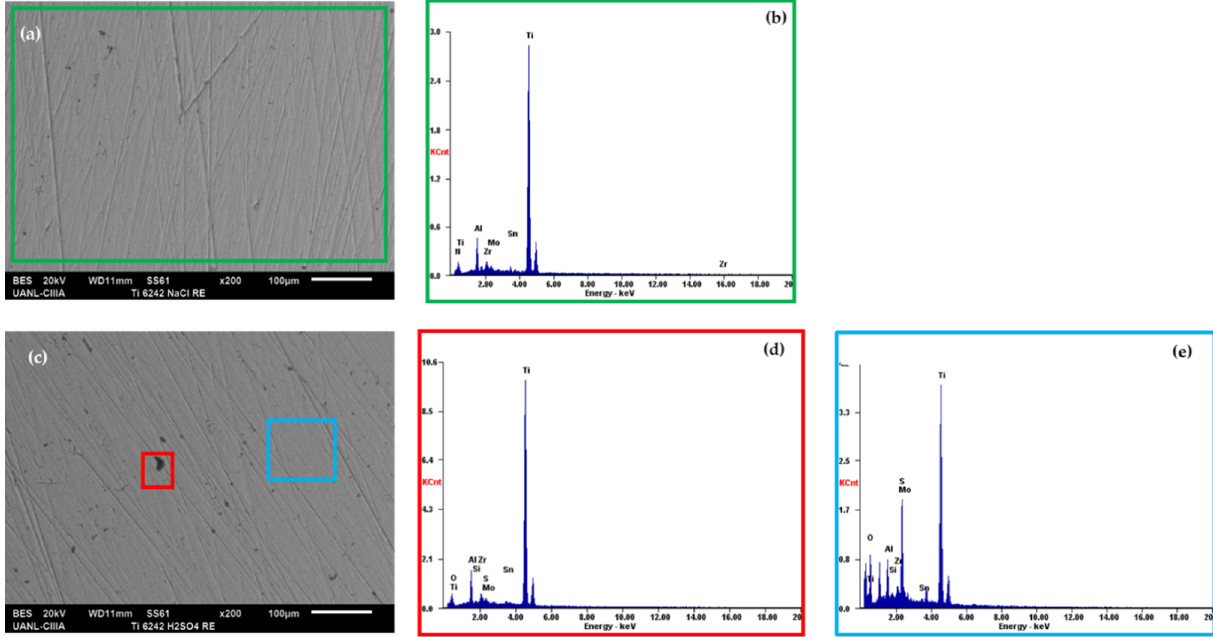
Figure 9. SEM-EDS surface morphology micrographs of Ti-6Al-2Sn-4Zr-2Mo alloys in ( a ) NaCl and ( c ) H 2 SO 4 solution; the rectangles show the areas where EDS analysis was performed for each image. ( b ) NaCl and ( d , e ) H 2 SO 4 .